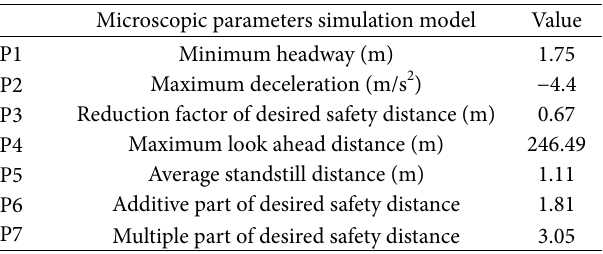
Table 1: Microscopic parameters related to driving